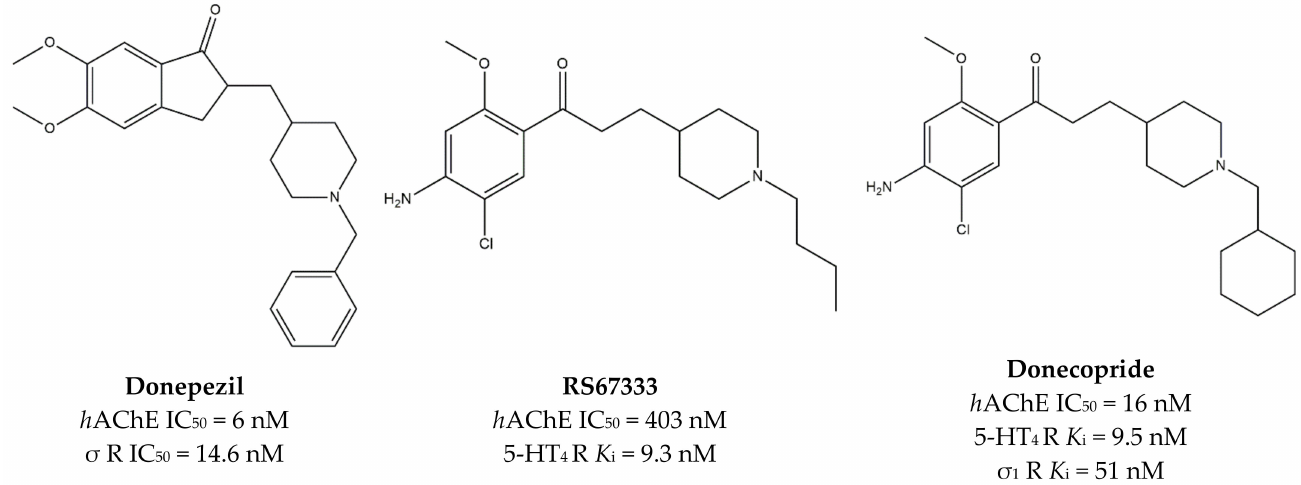
Figure 3. Donepezil , RS67333 , and Donecopride structures and their K i and IC 50 values for σ receptors ( σ R), σ 1 receptor ( σ 1 R), human acetylcholinesterase ( h AChE) and serotoninergic 5-HT 4 receptor (5-HT 4 R) [89–91].